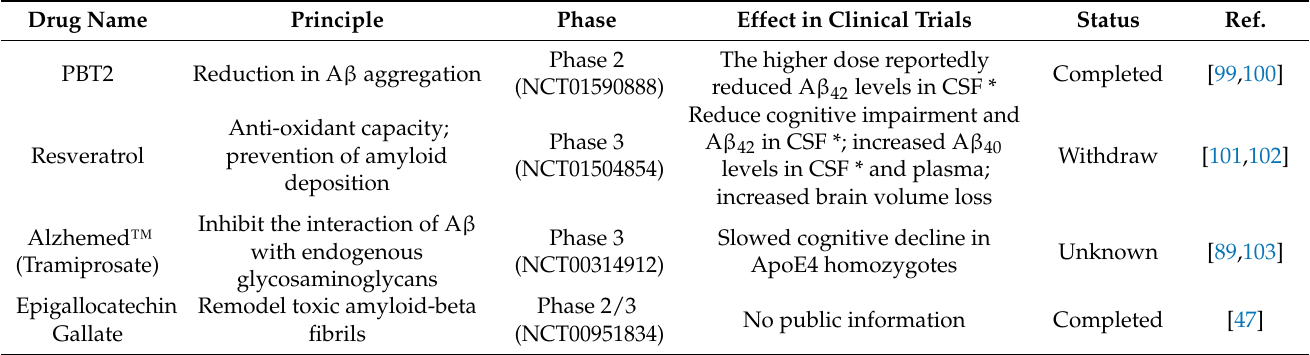
Table 2. Alzheimer drugs used to prevent A β